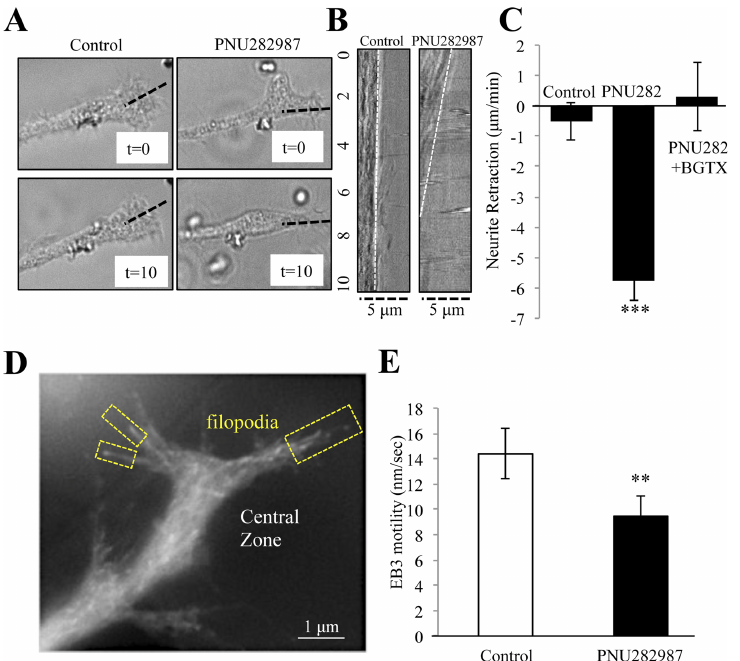
Fig 1. α 7 nAChRs activation drives to neurite retraction and inhibits microtubule growth. Brightfield imaging of the neurite and its growth cone in NGF differentiated PC12 cells treated with Control (DMSO) or 10 μ M of the α 7 nAChR specific agonist PNU282987 for 10 min. (A) Representative images of the growth cone at the beginning of the experiment (t = 0) and at the end of the experiment (t = 10). (B) Kymographs of the dotted line in (A) showing drug effect on neurite retraction during the experiment. (C) Average rate of neurite retraction for each group. (D) A representative image of EB3-RFP (EB3 comet) expression in the growth cone. (E) EB3 comet velocity in the growth cone following drug application. ( (cid:3)(cid:3)(cid:3) = p < 0.001; n = 10 cells per group).